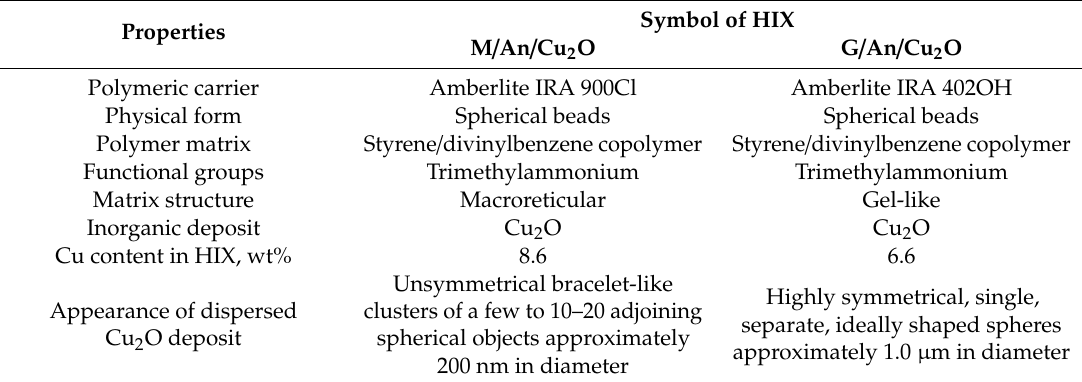
Table 2. Hybrid ion exchangers with Cu 2 O deposit.